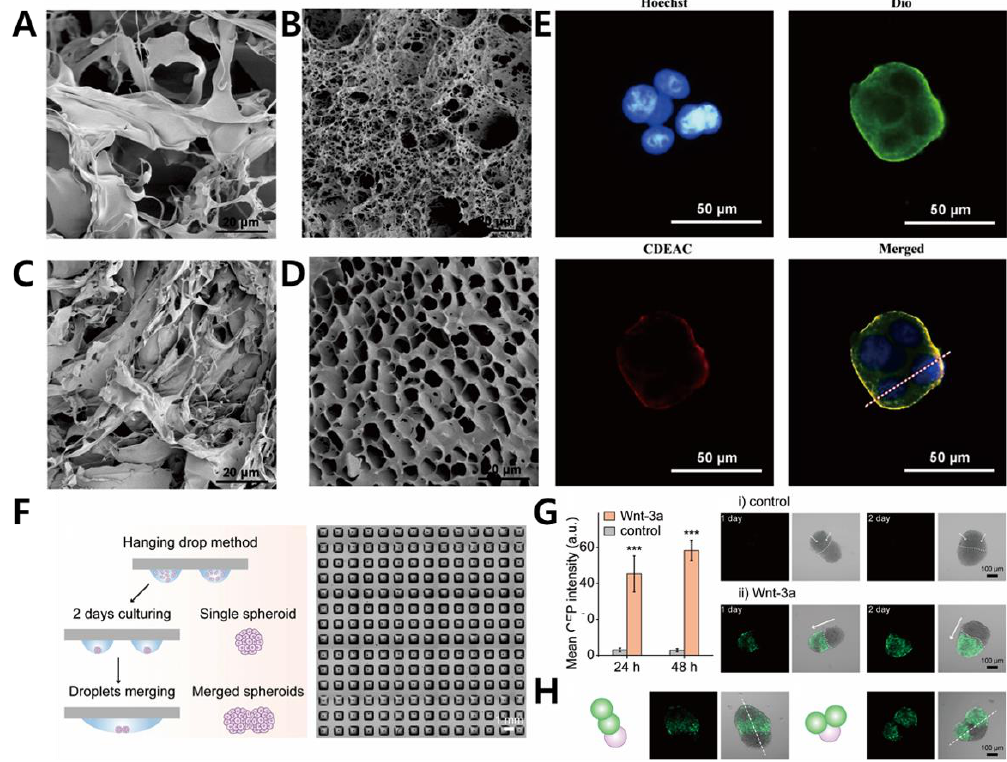
Figure 4. Morphology of the hydrogel platform after freeze-drying, investigated using scanning electron microscopy (SEM), with the SEM images of Eu (III) complex and carboxymethyl cellulose (CMC) backbone ( A ), the formed colloidally stable suspensions (CDEAC) ( B ), ClO − -added aqueous solution ( C ), and recovered state of the hydrogel upon addition of SCN − ( D ). ( E ) Multicellular cancer spheroids of MCF-7 from the CDEAC hydrogel stained with Hoechst (Blue), Dio (green), and CDEAC hydrogel (red). ( F ) Culture mechanism of the programmable assembly of spheroids with hydrophobic borders. ( G ) Calculated activation intensity of the multicellular complex of Wnt-3a and GFP-labeled HEK spheroids. (Intensity of GFP was estimated from at least 10 spheroids. ***, p < 0.001, one-way ANOVA). ( H ) Fluorescence microscopy of triple spheroids with Wnt producer spheroid and Wnt reporter spheroids. Reprinted with permission from [38]. Copyright 2019, Elsevier; reprinted with permission from [42]. Copyright 2020, Wiley Online